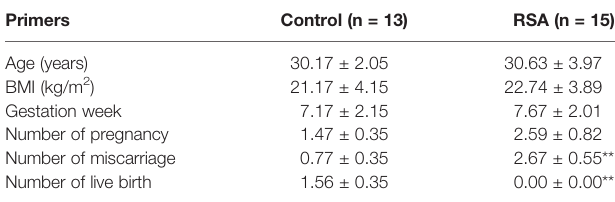
TABLE 2 | Clinical characteristics of the population.